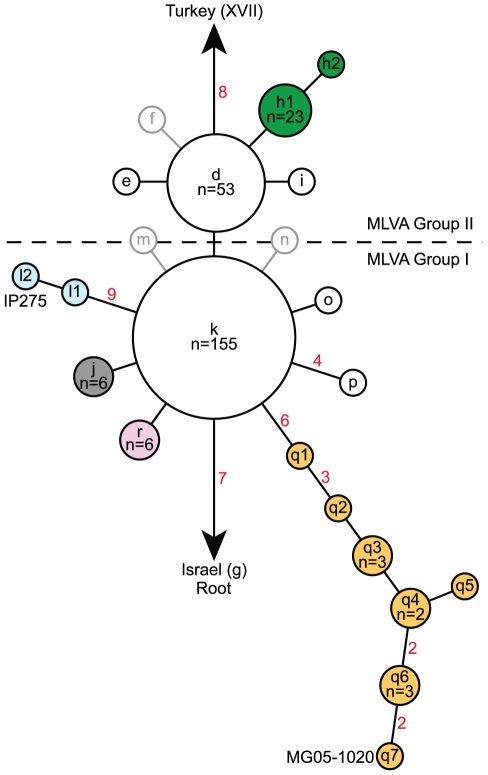
SNP phylogeny of 262 Malagasy isolates.Nodes were named as in Morelli et al. [1] (lower case letters) and belong to the 1.ORI3 group described there [1]. Previously identified nodes [1] that were expanded in this analysis (h, l and q) have additional number designations (e.g., q1) given to each new node in the expansions. The one entirely new node was assigned a new letter, “r.” Previously identified nodes [1] that were not represented by any isolates in this study are represented by gray outlines. Colored nodes correspond to MLVA-identified subclades and are colored the same as their matching MLVA subclades in Figure 2A–B. The number of isolates in nodes with >1 isolate are indicated as are the number of SNPs on branches (red numbers) with >1 SNP. The nodes containing the two sequenced Malagasy strains, MG05-1020 and IP275, are labeled with the strain names.